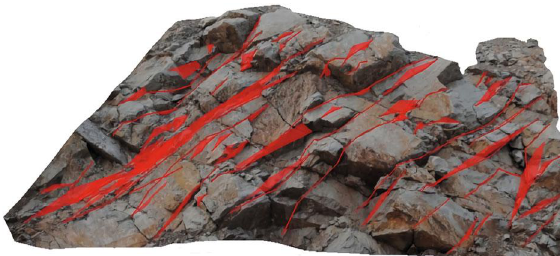
Figure 1: Natural cracks on the tunnel face